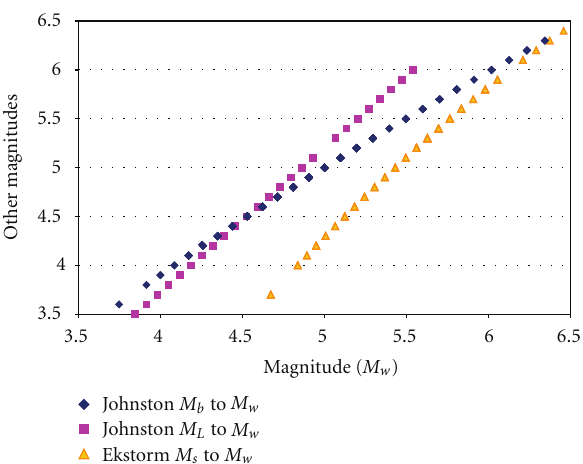
Figure 3: Empirical relationships for conversion between magni- tudes scales.